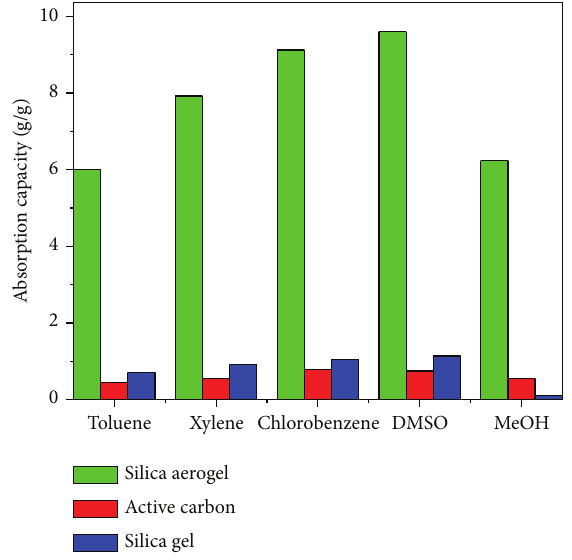
Figure 7: Adsorption capacities of various